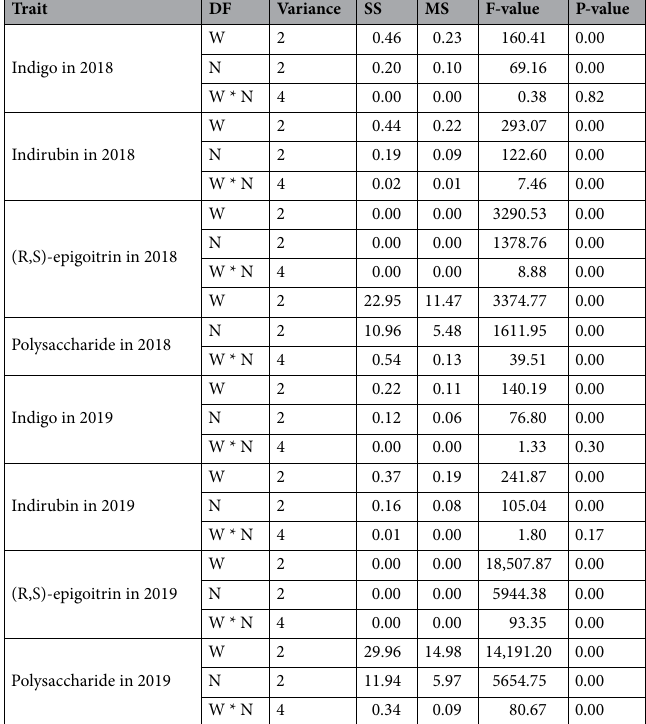
Table 4. Variance analysis of traits the quality of Isatis indigotica